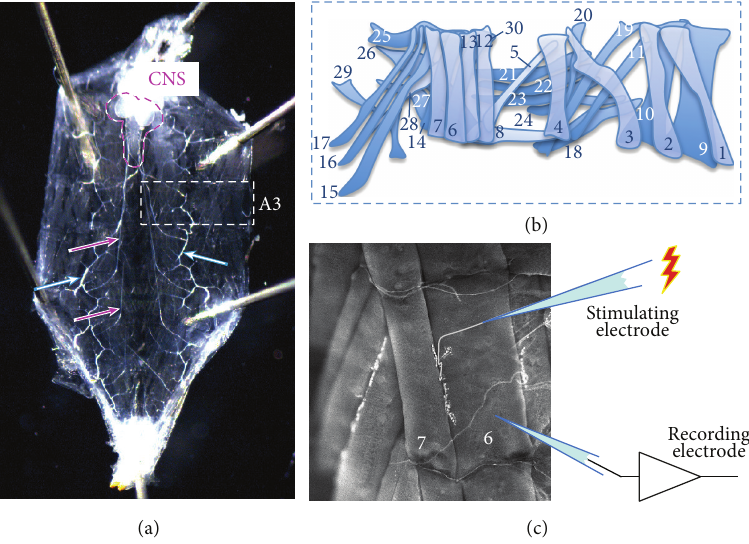
Figure1:Theconsistent Drosophila larvalNMJ.(a)Dissectionofthirdinstar Drosophila larvaerevealsadistinctbodyplan,whichisconsistent between all larvae, comprised of 14 segments, 3 of which define the head and mouth region, 3 thoracic segments (T1–T3), and 8 abdominal segments (A1–A8; segment A3 indicated by the white dotted line). The CNS is outlined in magenta, the main nerve trunks indicated by magenta arrows. The trachea, which supply oxygen to the nerves and muscles remain intact, and two are indicated by the light cyan arrow. (b) Abdominal segments A2–A7 are composed of 2 bilaterally symmetrical hemisegments, each of which displays an archetypal structure comprising 30 distinct muscles. (c) These hemisegments have been extensively studied with a number of specific NMJs utilised as model synapses for a range of experimental purposes. Here we show muscle 6/7 (hemisegment A3). This muscle pairing has been extensively used for electrophysiological experiments due to the large size and accessibility of the NMJ, with the presynaptic motor neuron clearly visible innervating muscles 6 and 7. In this diagram we demonstrate how a suction electrode can be used to stimulate a single segmental nerve whilst recordings are made from muscle 6 (the larger of the